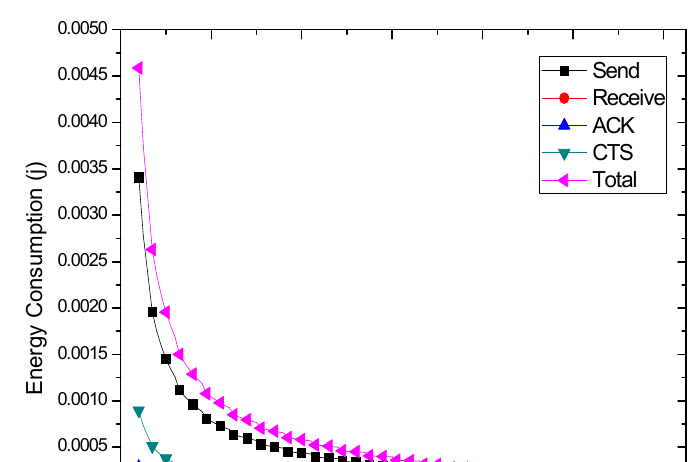
Figure 6. Packet load in different areas.